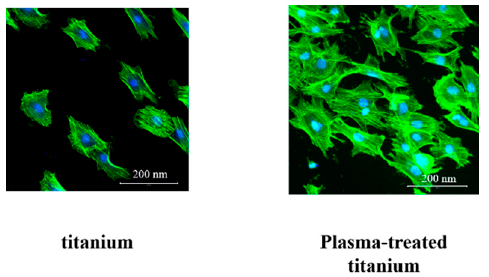
Figure 7. RBM cell morphology of titanium and plasma-modified titanium. The RBM cells adhering to plasma-treated titanium showed greater F-actin expression and more filopodia and lamellipodia than those on the titanium surface.